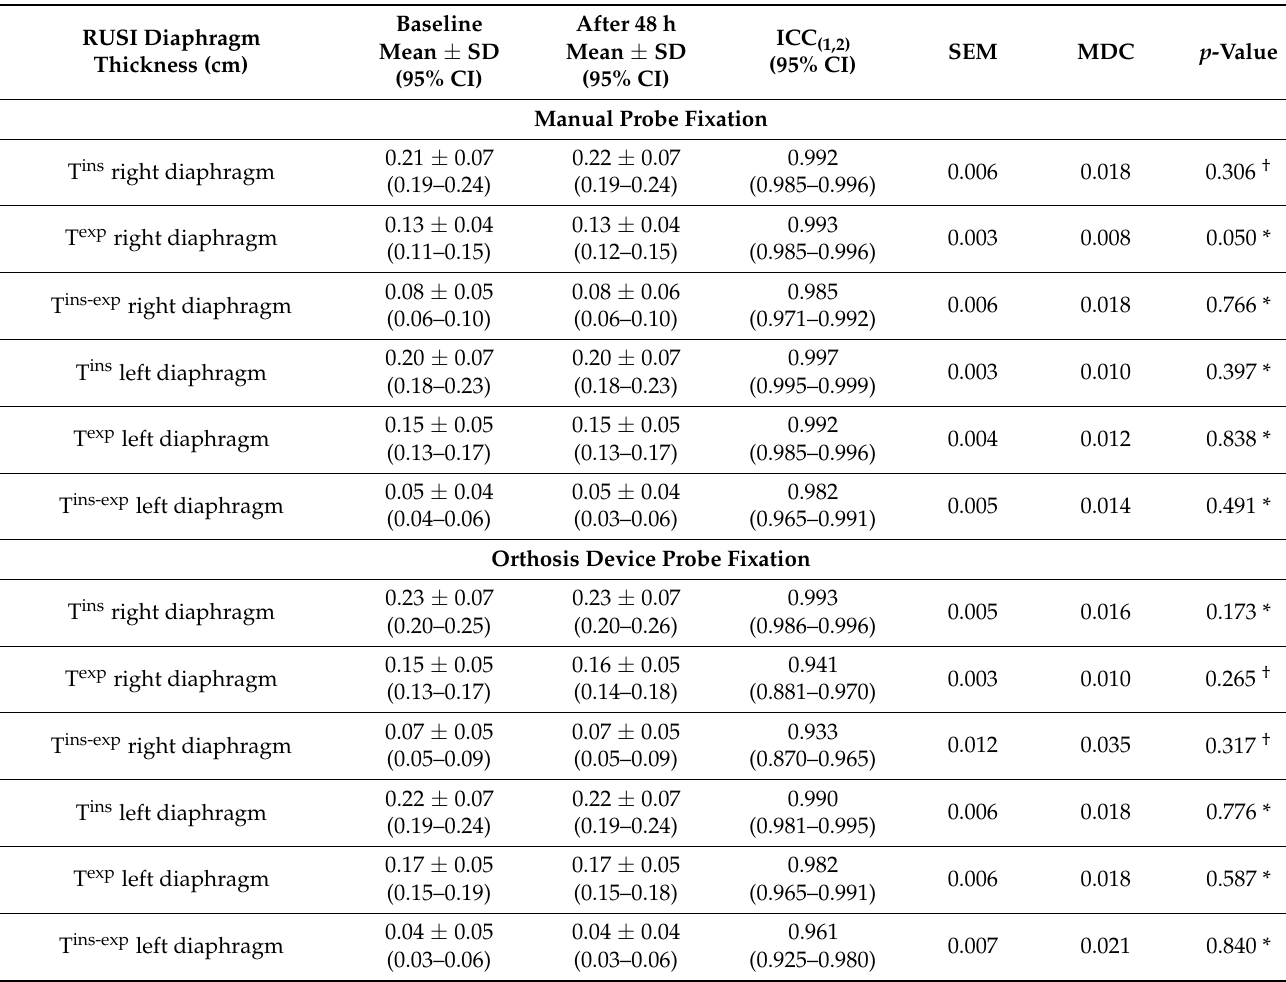
Table 2. Intra-rater and inter-session reliability analysis for RUSI diaphragm thickness within both manual and specific orthosis device measurement methods during relaxed